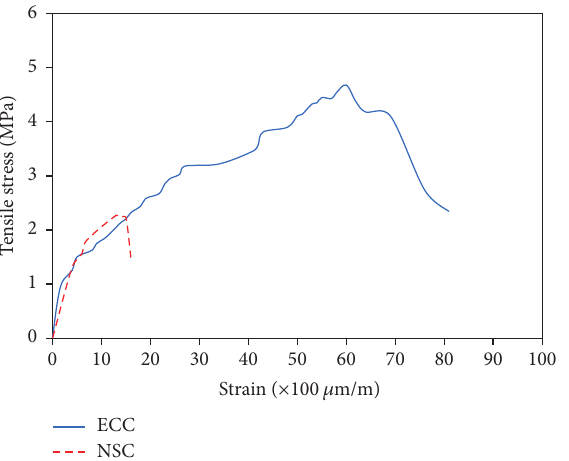
Figure 17: Direct tensile strength: ECC and NSC.